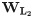
Schema of the network inferring method.(a) The microarray data corresponding to the parasite’s four steady states are normalised. (b) The total of 8,904 gene-expression levels of each stage is reduced to 339 clusters representing the variables of our systems. (c) An ensemble of 300 training sets including fluctuations around the steady states is constructed from the steady states. Using singular value decomposition (SVD), the minimal L2-norm solution for each Dss is determined. (d) A sparse connectivity matrix, Wss, is derived from the probability distribution Pij(w) by using a pruning method based on a location test. (e) A new training set is constructed from the transitions between the amastigote (A), epimastigote (E), metacyclic tryp. (M) and trypomastigote (T) stages. Intermediate states (small circles) between the stages are assumed to exist. It is also considered that an unknown external cue (black arrow) is responsible for the transitions. (f) By means of using SVD, the L2-norm solution, WL2, is determined. This solution is in turn used to find another solution, Wt, which includes information concerning the steady states. This procedure is used to infer the weighted links between genes, wi,j, and to answer two questions: which genes are affected by the external cues, and how they are regulated (up or down) by the environment.